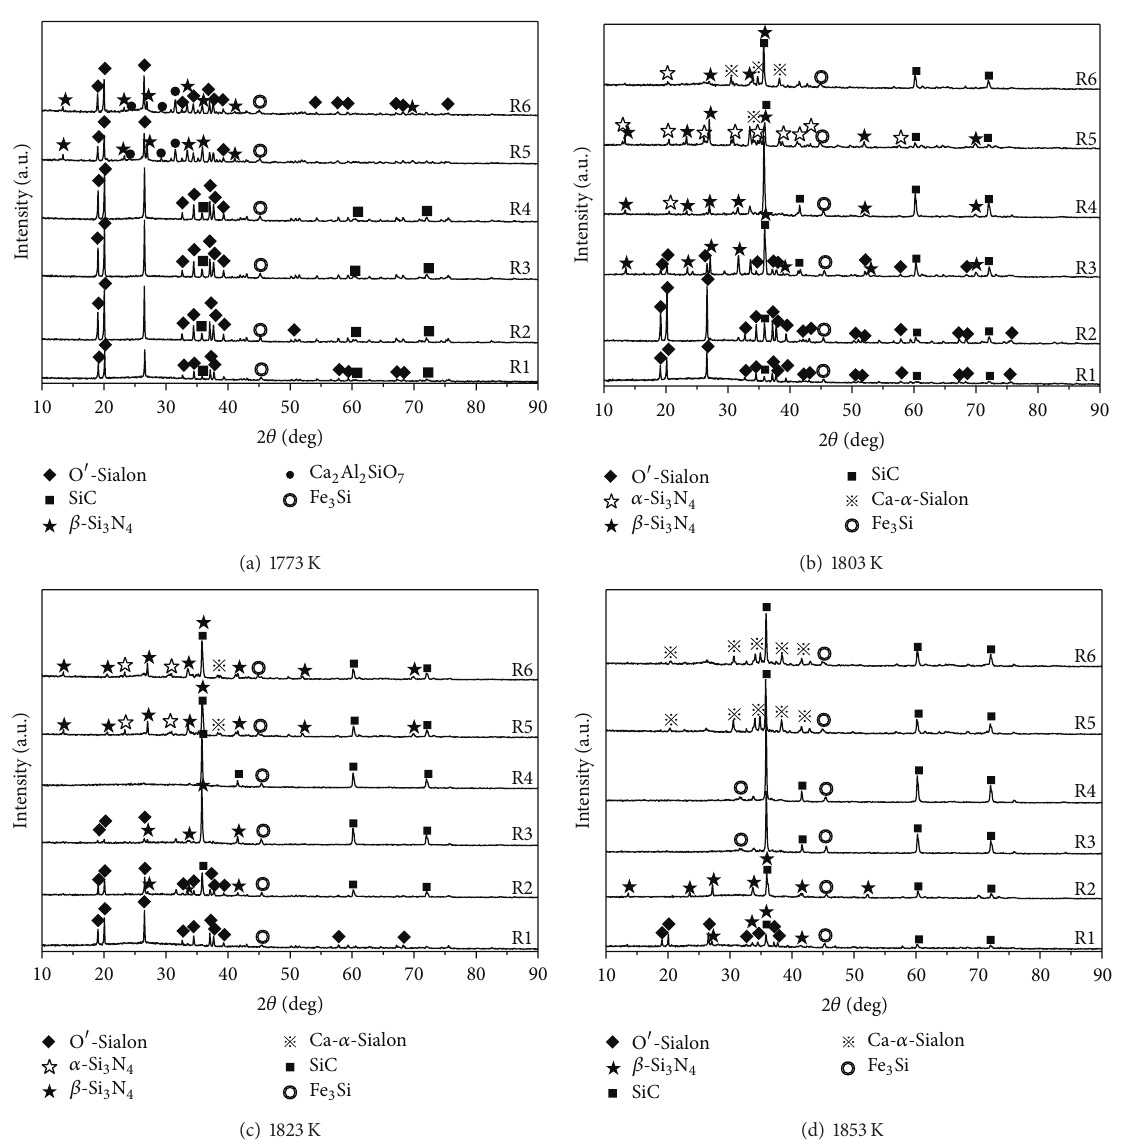
Figure 2: XRD patterns of samples after calcination at different temperatures for